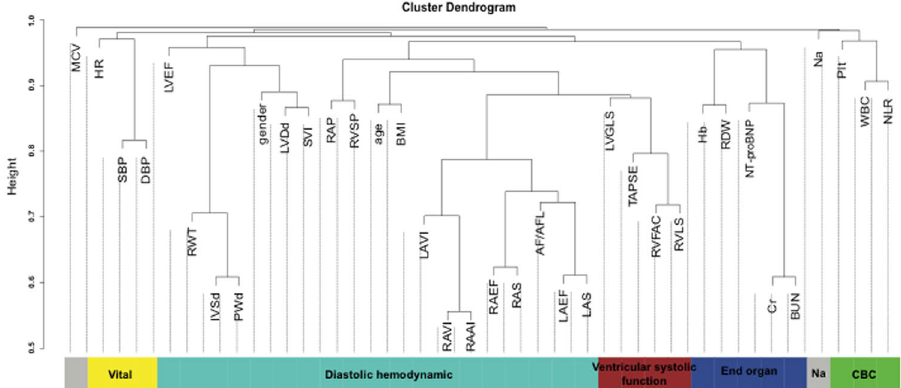
Figure 3. Cluster Dendrogram of clinical, laboratory and echocardiographic echocardiographic features. Dynamic tree cut algorithm detected six clusters of closely associated features shown in blue, brown, green, red, yellow, and turquoise. AF; atrial fibrillation, AFL; atrial flutter, BMI; body mass index, BUN; blood urea nitrogen, Cr; creatinine, DBP; diastolic blood pressure, eGFR; estimate glomerular filtration rate, Hb; hemoglobin, HR; heart rate, IVSd; diastolic interventricular septum, LAEF; left atrial emptying fraction, LAS; left atrial strain, LAVI; left atrial volume index, LVDd; diastolic left ventricular dimension, LVEF; left ventricular ejection fraction, LVLS; left ventricular longitudinal strain, LVMI; left ventricular mass index, MCV; mean corpuscular volume, Na; sodium, NLR; neutrophil-to-lymphocyte ratio, NT-proBNP; N-terminal pro B-type natriuretic peptide, Plt; platelet, PWd; diastolic posterior wall, RAAI; right atrial area index, RAEF; right atrial emptying fraction, RAP; right atrial pressure, RAS; right atrial strain, RAVI; right atrial volume index, RDW; red cell distribution width, RVFAC; right ventricular fractional area change, RVLS; right ventricular longitudinal strain, RVSP; right ventricular systolic pressure, RWT; relative wall thickness, SBP; systolic blood pressure, SVI; stroke volume index, TAPSE; tricuspid annular plane systolic excursion, WBC; white blood cell.